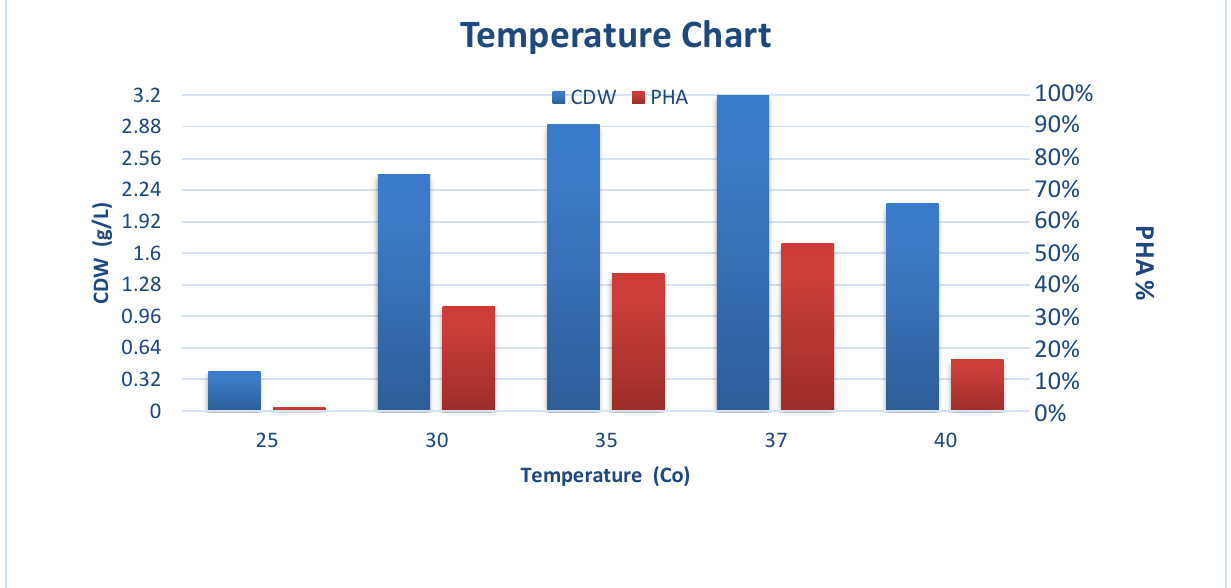
Figure 4: Effect of different incubation temperatures on biomass and PHA yield with A. lwoffii G3.